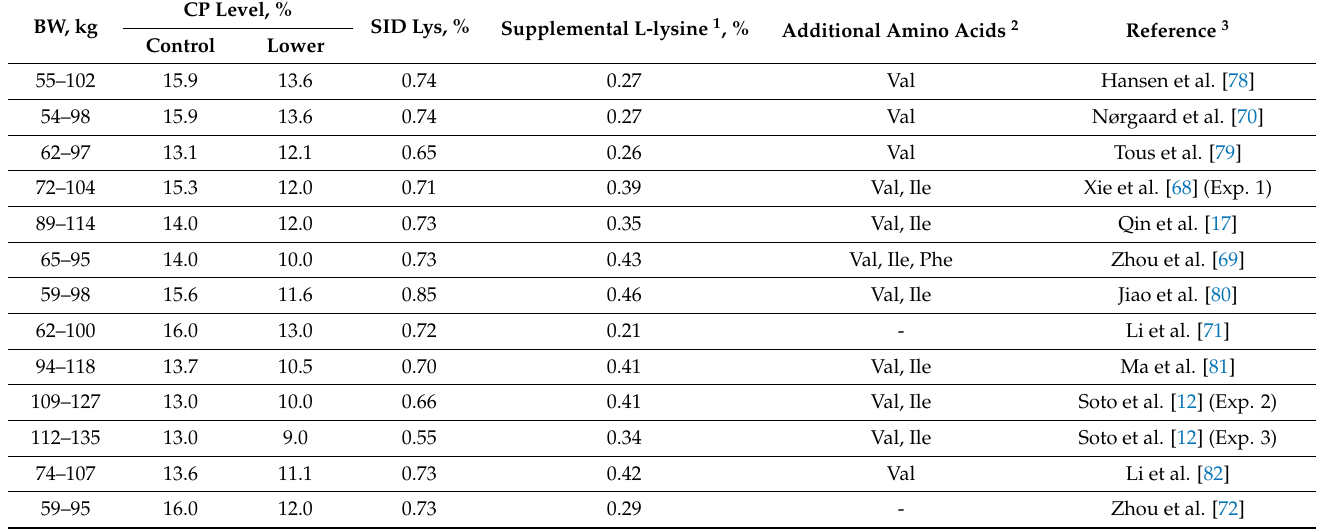
Table 3. Summary of the studies included in the meta ‐ analysis to estimate changes in average daily gain and gain to feed in the finishing phase.